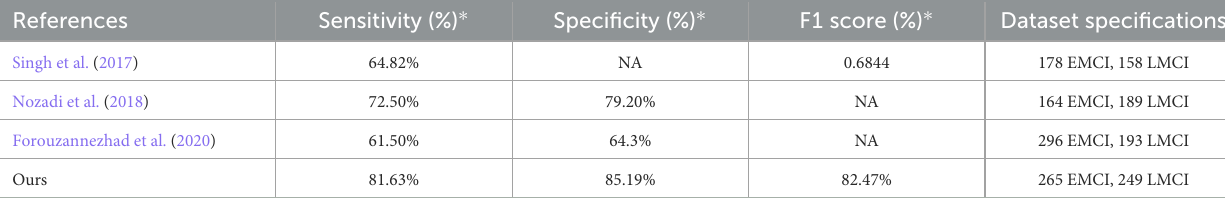
TABLE 5 Comparison of performance between our model and other existing methods in prediction of EMCI and